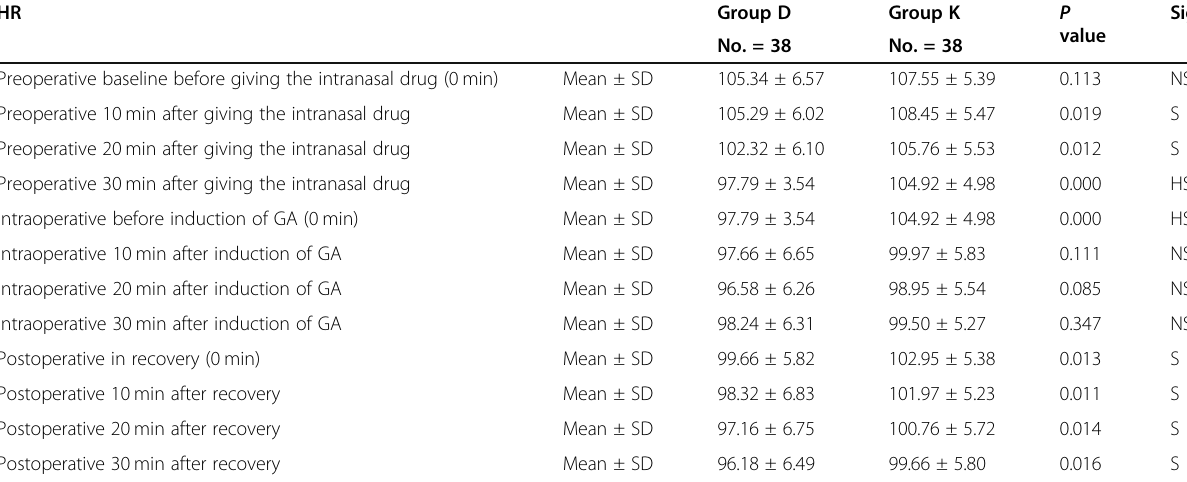
Table 6 Comparison between group D and group K as regards heart rate (HR)